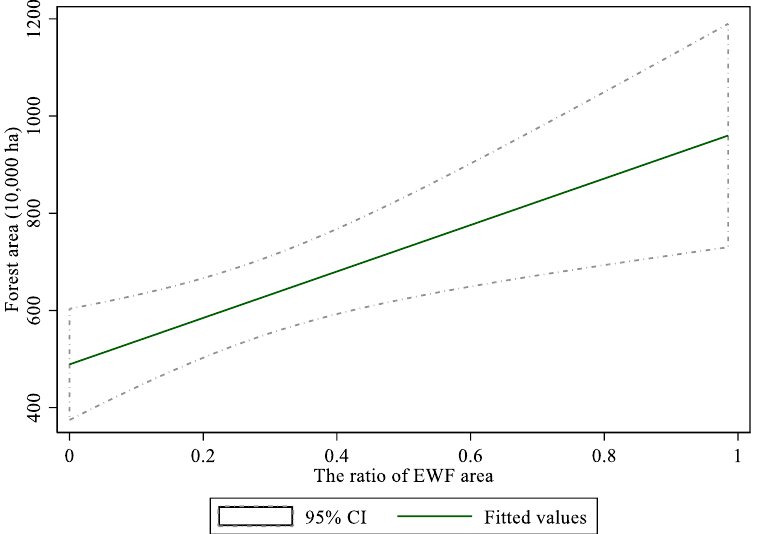
Figure 1. Correlation between the ratio of EWF area and forest restoration.